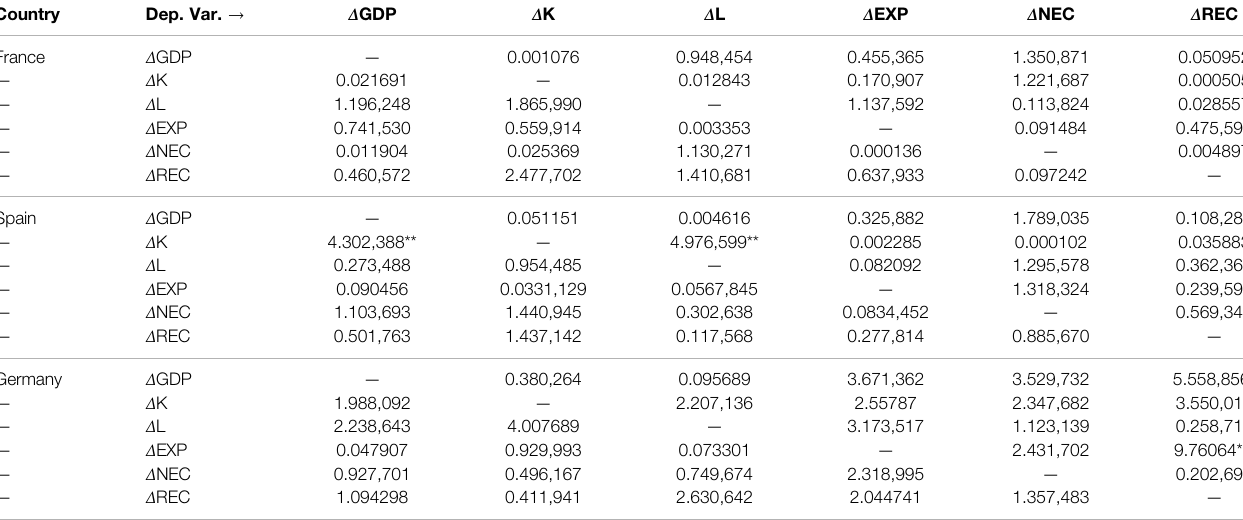
TABLE 11 | Results of the Granger causality (1969, 1988) test. Country Dep. Var.